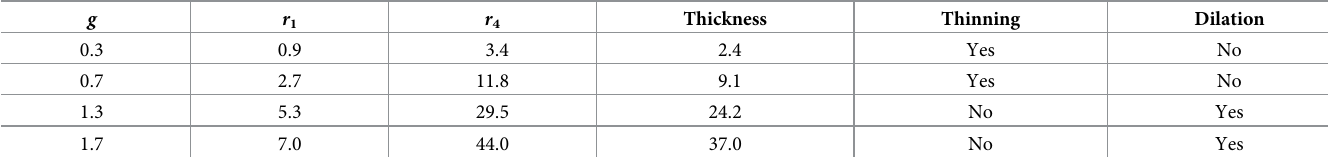
Table 1. Cervical wall thinning and dilation results for isotropic growth with g = g r = g θ = g z . Length unit: mm. g